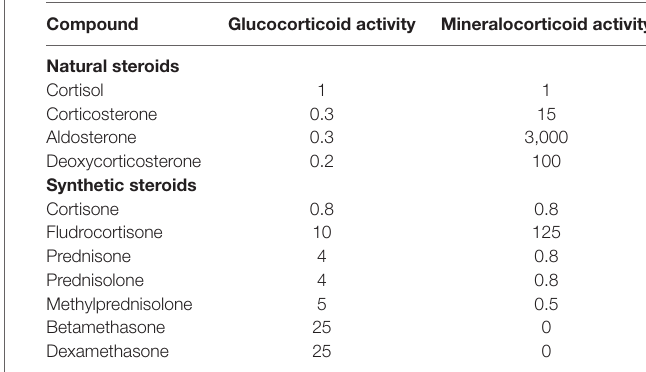
TaBle 1 | Relative potencies of natural and synthetic